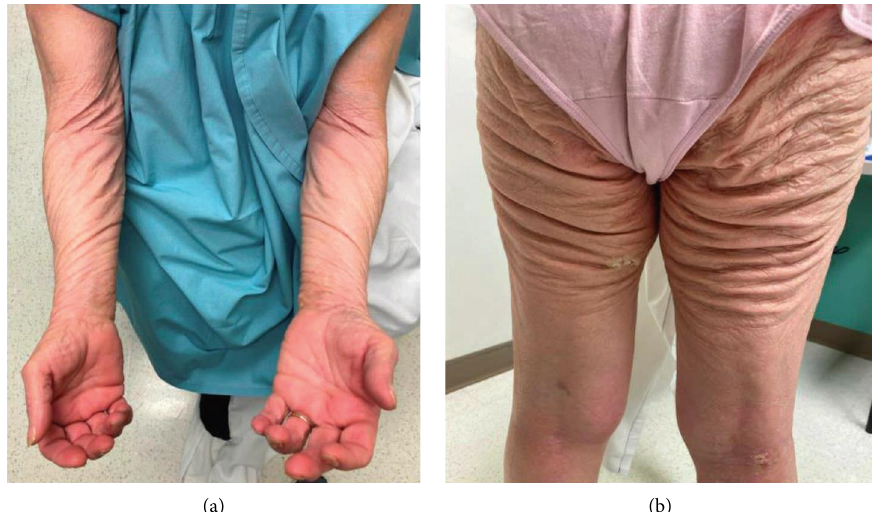
Figure 1: Clinical photographs show areas of difuse indurated, sagging skin, with decreased elasticity and fne scaling. (a) Ventral forearms and wrists. (b) Posterior thighs.